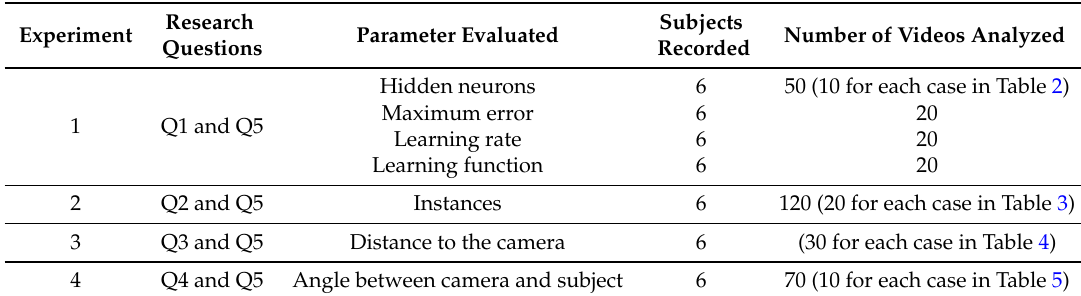
Table 1. Summary of the experiments